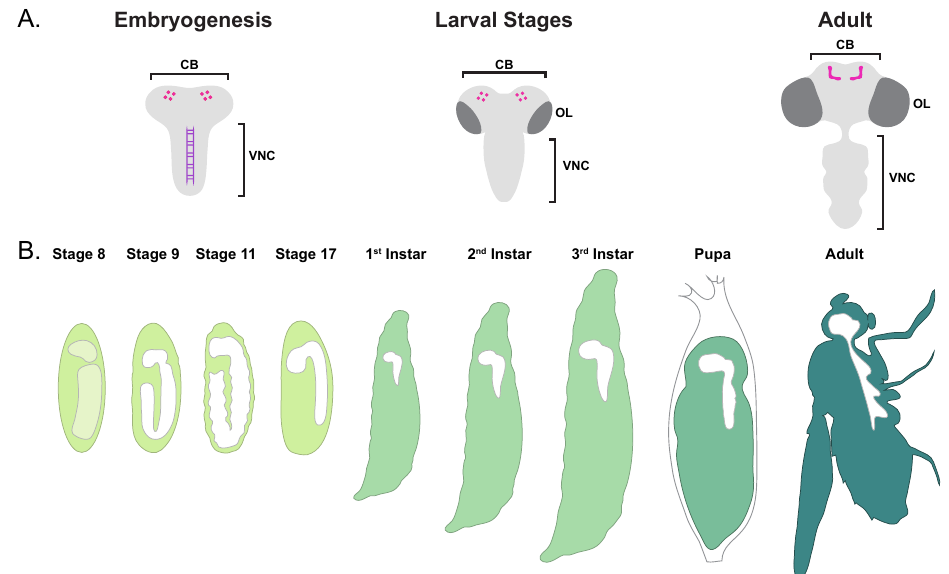
Figure 4. Drosophila central nervous system (CNS) development. ( A ) A schematic of the embryonic, larval, and adult Drosophila CNS. The central brain (CB), ventral nerve cord (VNC), and optic lobes (OL) are labeled. The embryonic midline is indicated in purple, and the mushroom body neuroblasts, as well as the fully formed mushroom bodies in the adult, are depicted in magenta (not to scale). ( B ) A schematic depicting the sagittal view of the developing CNS. Shown are four embryonic followed by larval, pupal and adult stages. In Stage 8 of embryogenesis, prior to delamination, the neurogenic regions which give rise to the brain and VNC are shown in light green. In subsequent stages, the nervous system is shown in